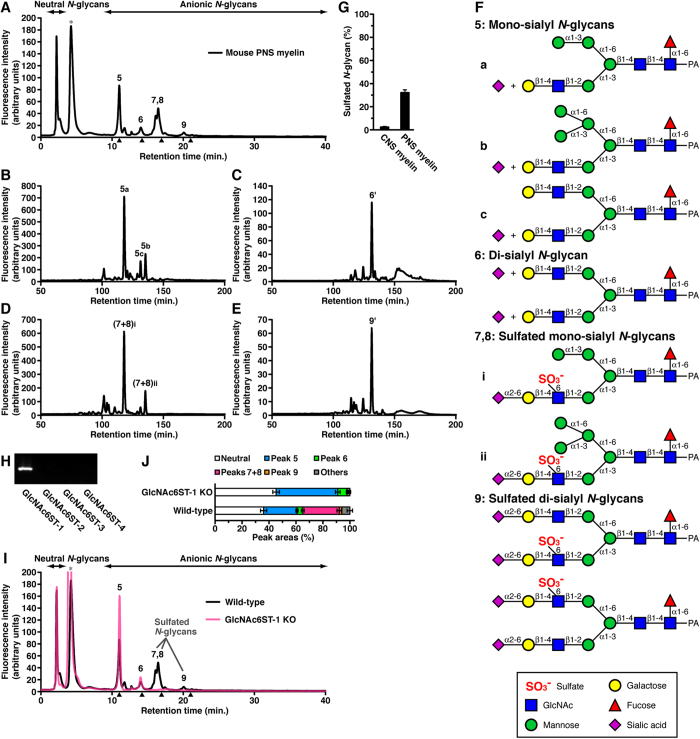
GlcNAc6ST-1 exclusively catalyzes sulfation of N-glycans in mouse PNS myelin.(A) PA-N-glycans from young adult mouse PNS myelin were analyzed by DEAE HPLC. Peaks 5–9 were numbered in order of elution time from the anionic fractions. The elution positions of peaks 5 and 6 were mono- and di-sialyl N-glycans, respectively. The peak 5–9 fractions were collected and further analyzed individually. The asterisk indicates the peak derived from contaminants. Arrowheads indicate the elution positions of mono-, di-, tri-, and tetra-sialyl standard PA-oligosaccharides. (B–E) The anionic fractions of peaks 5 (B), 6 (C), 7 + 8 (D) and 9 (E) from mouse PNS myelin were individually analyzed by NP-HPLC after desialylation (peaks 5 and 6) and desulfation (peaks 7 + 8 and 9). The major peaks 5a, 5b, 5c (B), 6′ (C), (7 + 8)i, (7 + 8)ii (D) and 9′ (E) were numbered. (F) The N-glycans of peaks 5a, 5b, 5c (B), 6′ (C), (7 + 8)i, (7 + 8)ii (D) and 9′ (E) in Fig. 2B–E were further analyzed (Supplementary Fig. S3), and the N-glycan structures from peaks 5–6 were identified. (G) The percentages of sulfated N-glycans from mouse CNS and PNS myelin were measured. Error bars indicate the mean ± SD (CNS myelin, n = 4; PNS myelin, n = 7). (H) The mRNA expression levels of four GlcNAc6STs in sciatic nerves were analyzed by RT-PCR. (I) PA-N-glycans from PNS myelin of young adult GlcNAc6ST-1-KO mice (red) were separated using a DEAE column. The elution positions of peaks 5–8 coincided with those from PNS myelin of WT mice (black; Fig. 2A). (J) The percentages of N-glycans from PNS myelin of young adult WT and GlcNAc6ST-1-KO mice were measured as the peak areas on DEAE HPLC. Error bars indicate the mean ± SD (WT mice, n = 7; GlcNAc6ST-1-KO mice, n = 3).